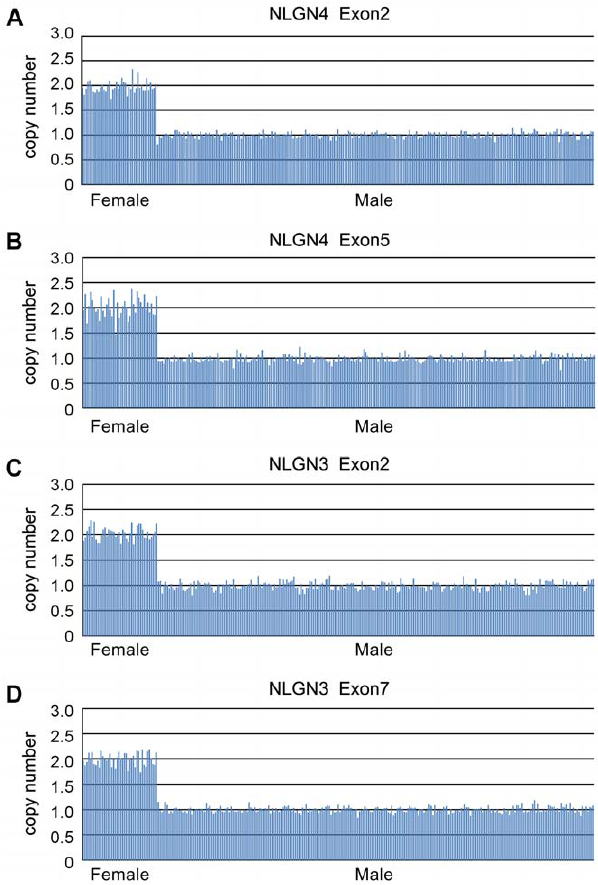
Figure 2. Assays of copy number in X-linked NLGN4 and NLGN3 genes. The copy number states of two segments for each gene for each ASD patient were shown in two panels. Panel A: exon2 of NLGN4 ; Panel B: exon5 of NLGN4; Panel C: exon2 of NLGN3 ; Panel D: exon7 of NLGN3 . Each column indicates a patient. All female ASD cases showed two copy of NLGN4/NLGN3 and male ASD cases had one copy of NLGN4/NLGN3 . doi:10.1371/journal.pone.0056639.g002 Figure 3. Assays of copy number in SHANK2 and SHANK3 genes.